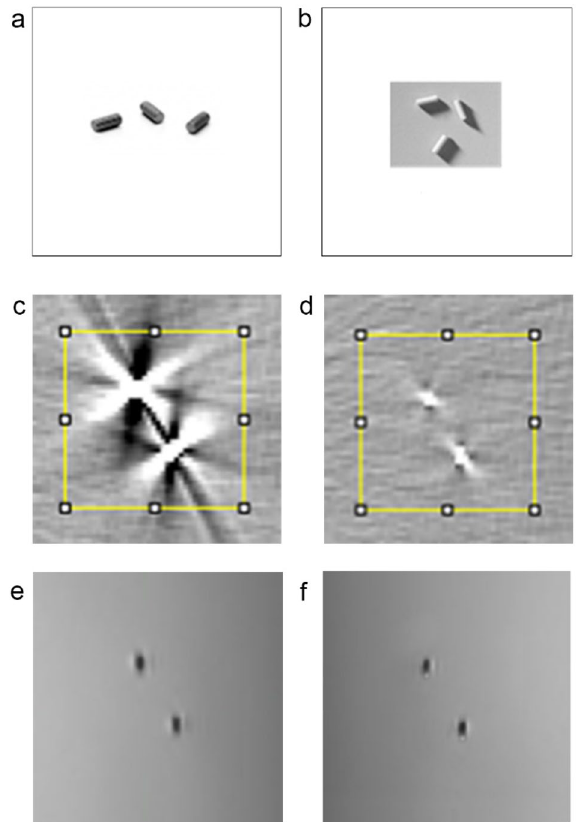
Figure 1. ( a ) Gold seeds, ( b ) Polymer seeds, ( c ) CT of gold seeds with the defined area for the gray-scale histogram, ( d ) CT of polymer seeds with the defined area for the gray-scale histograms, ( e ) MR Co-registered with CT of gold seeds and ( f ) MRI Co-registered with CT of polymer